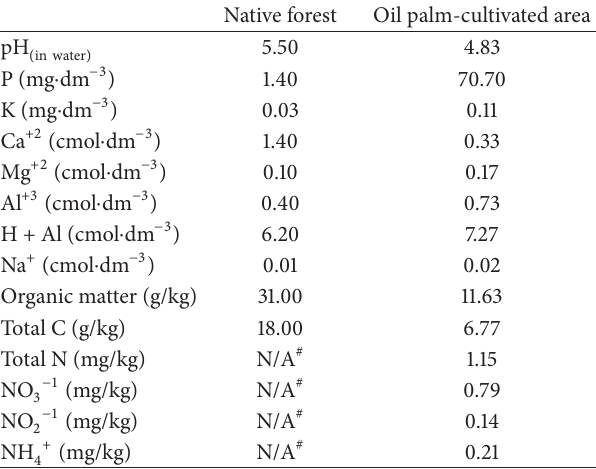
Table 2: Physicochemical properties of native forest soil and soil under oil palm